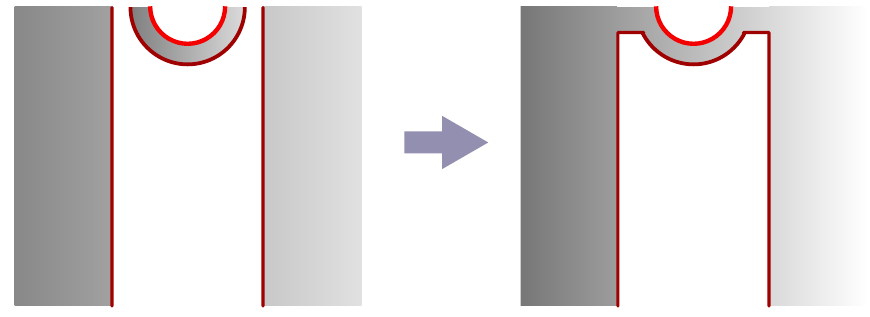
Figure 9 . 2D model for an evaporating black